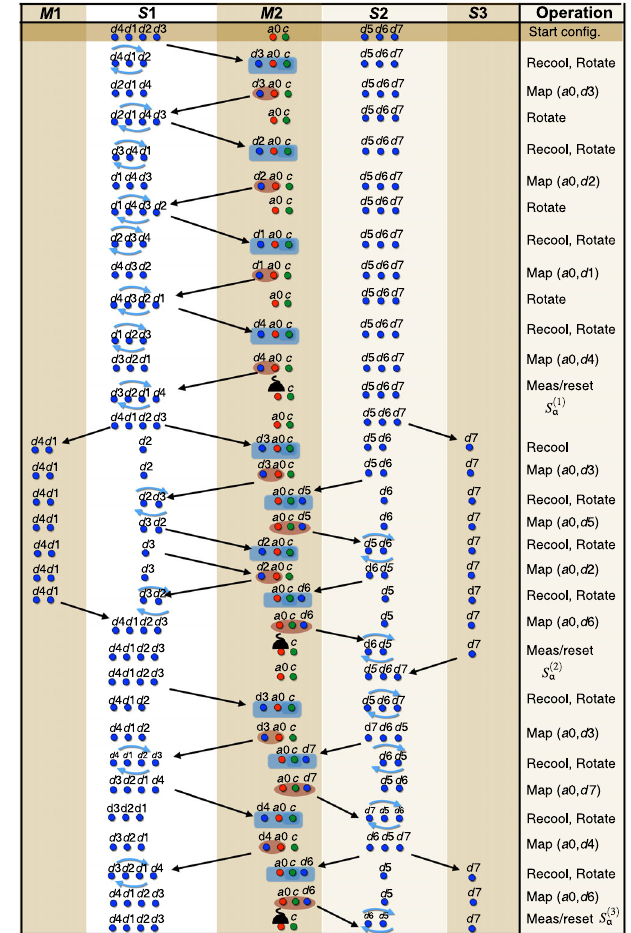
FIG. 19. Real-space representation of shuttling-based two- species QEC cycle with two-qubit MS gates: We represent half of a cycle of QEC for the sequential measurement of 1 Þ ð 2 Þ ð 3 Þ f S ð α ; S α ; S α g , either for α ¼ x or for z , and use the same conventions as in Figs. 15 and 18, placing the extra cooling ion (green circle) in the manipulation zone M 2 . In the rightmost column, we specify the time steps when crystal-reconfiguration operations, sympathetic recooling, and ancilla measurement/reset take place. The new mapping functions, represented by red ellipses, consist of the data-ancilla conditional gate Map ð a 0 ; dj Þ ¼ U ð a 0 ;d j Þ x for a X -type stabilizer or its combination π = 2 Þ U ð a 0 ;d j Þ − π = 2 Þ with local rotations Map ð a 0 ; dj Þ ¼ Y x Y d j ð d j ðþ for a Z -type stabilizer. We recall that these local rotations can be obtained from the available set of gates in θ Þ ¼ Eqs. (5) and (6) by simple refocusing sequences Y d j ð θ = 2 Þ U π Þ U − θ = 2 Þ U − π Þ U R ; π = 2 ð R dj ;z ð R ; π = 2 ð R dj ;z ð